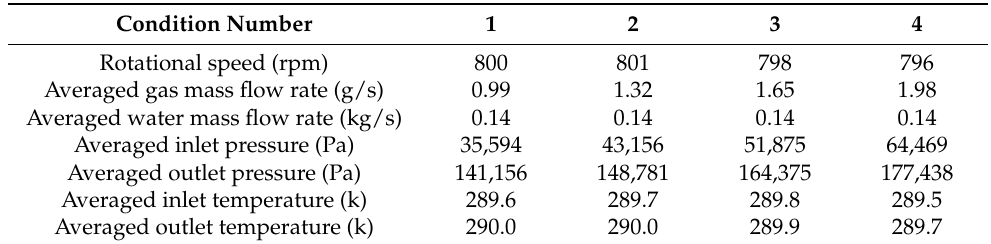
Table 3. Measured values in the conditions of the experiment. Reprinted with permission from ref.